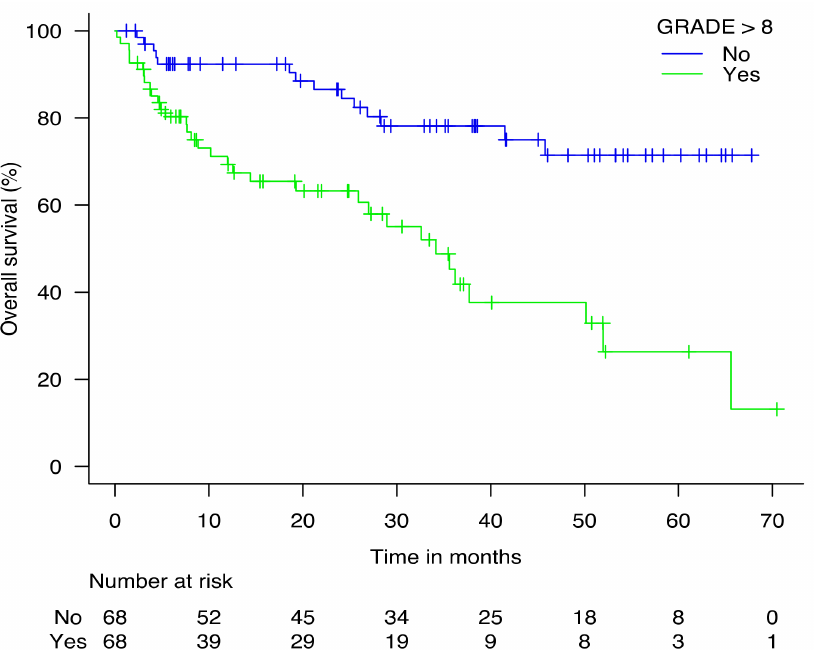
Figure 2. 5-year Kaplan-Meier survival according to the GRADE score for 136 older patients with major cancer